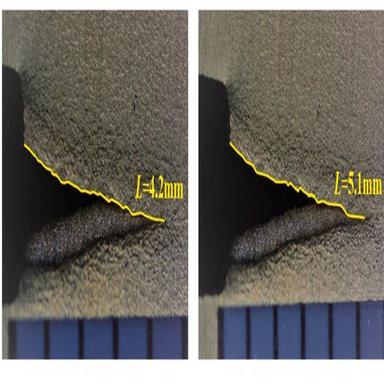
Captured photographs of the crack configuration at different locations along the path of mode I crack propagation.